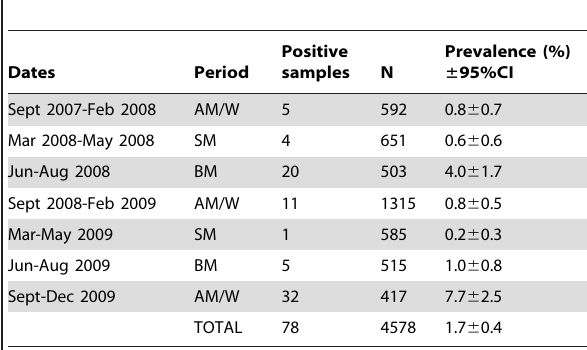
Table 2. Sampling effort and AIV detection according to the different sampling